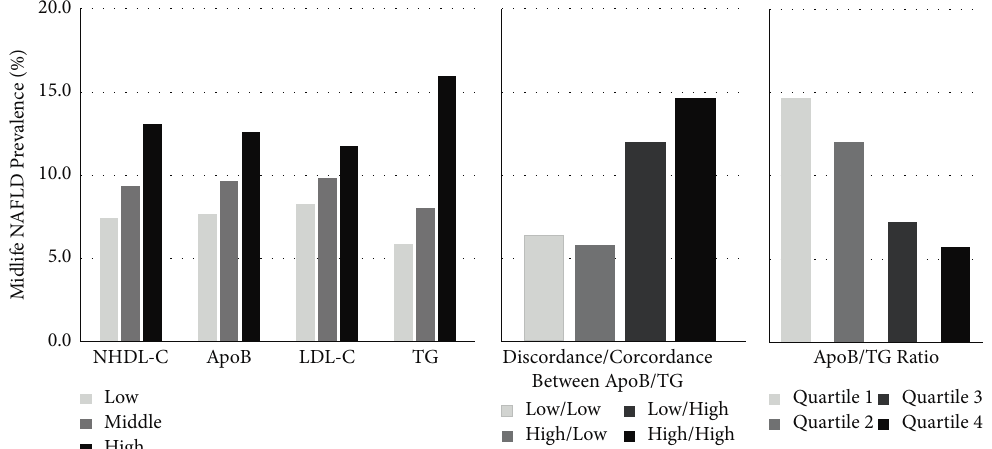
Figure 2: Midlife NAFLD Unadjusted Prevalence Stratified by NHDL-C, ApoB, or LDL-C tertiles, Discordance/Concordance Groups, and ApoB/TG Ratio Quartiles in Young Adulthood. Median NHDL-C: 121.0mg/dL. Tertile ranges are low (36.0 to 107.0 mg/dL), middle (108.0 to 136.0mg/dL), and high (137.0 to 288.0mg/dL). Median ApoB: 88.0 mg/dL. Tertile ranges are low (22.0 to 78.0mg/dL), middle (79.0 to 98.0mg/dL), and high (99.0 to 292.0mg/dL). Median LDL-C: 107.0mg/dL. Tertile ranges are low (21 to 95mg/dL), middle (96 to 120 mg/ dL), and high (121 to 260mg/dL). Median TG: 60.0mg/dL. Tertile ranges are low (16 to 49 mg/dL), middle (50 to 72mg/dL), and high (73 to